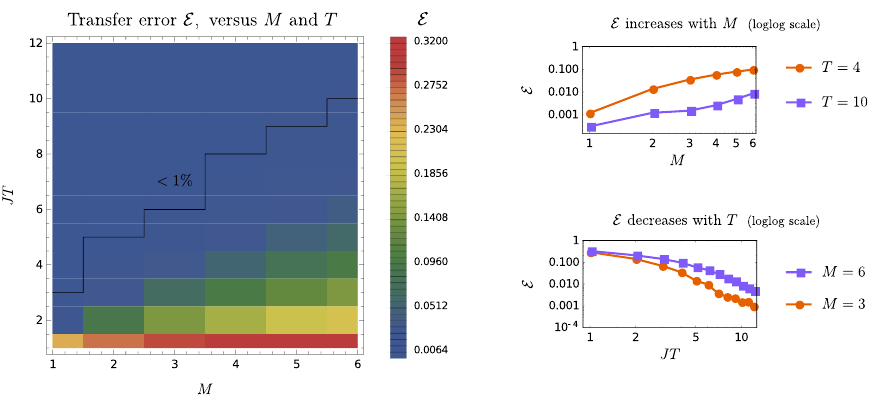
Figure 6: Transfer fidelity E for various choices of T and M , for systems with arm length K = 2. For the small systems that we study, the fidelity seems to quickly converge to errors of less than 1%, indicated by the black zig-zag line, for protocol times just slightly larger than the intrinsic time scale 1 / J of the system. On the right, cutouts of the main plot are displayed for fixed times (top) and fixed number of arms (bottom) on a log-log